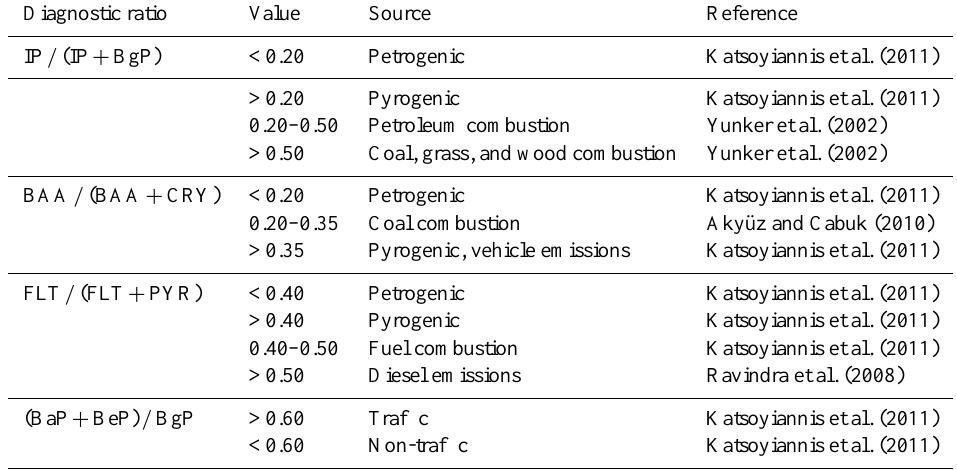
Table 3. PAH diagnostic ratios for different source categories. The PAH abbreviations are IP: indeno(123cd)pyrene; BgP: benzo(ghi)perylene; BAA: benz(a)anthracene; CRY: chrysene; FLT: fluoranthene; PYR: pyrene; BeP: benzo(e)pyrene; BaP: